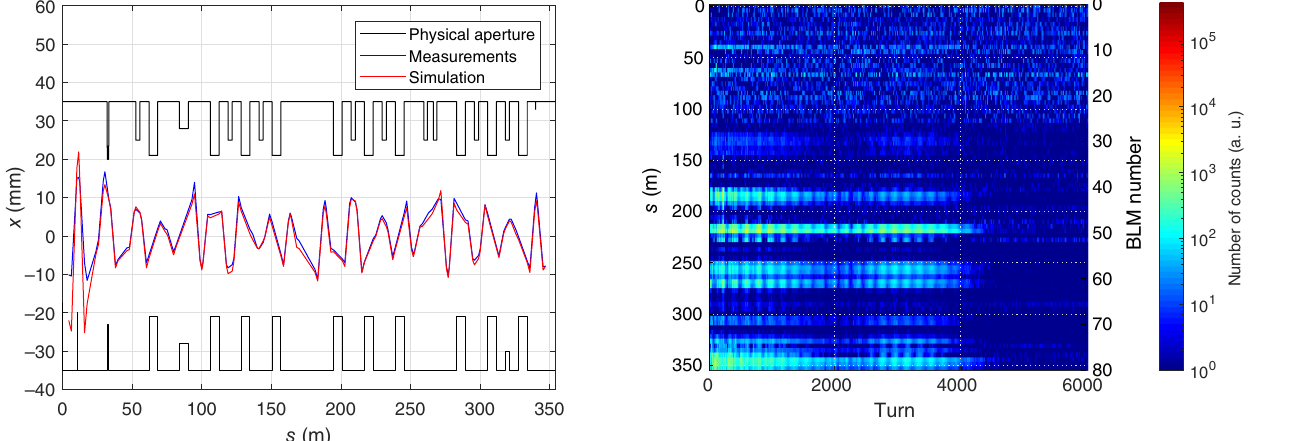
FIG. 19. Turn-by-turn losses distribution in the case of the standard injection scheme. BLMs 1 to 25 monitor the beam losses from the injection to the MIK sections.